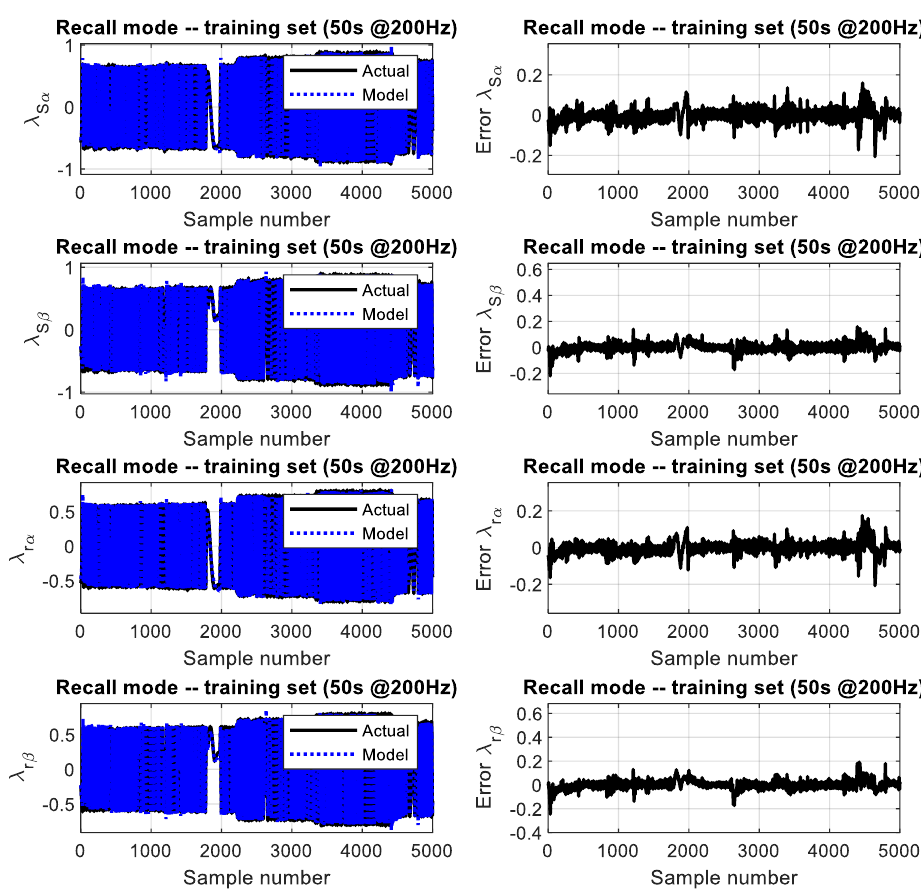
Figure 13. Network performance considering the measured stator and rotor fluxes and estimated ones.